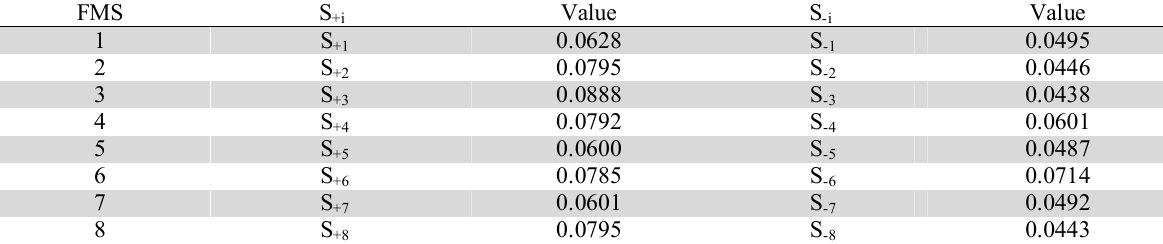
Sums of the weighted normalized values for COPRAS method